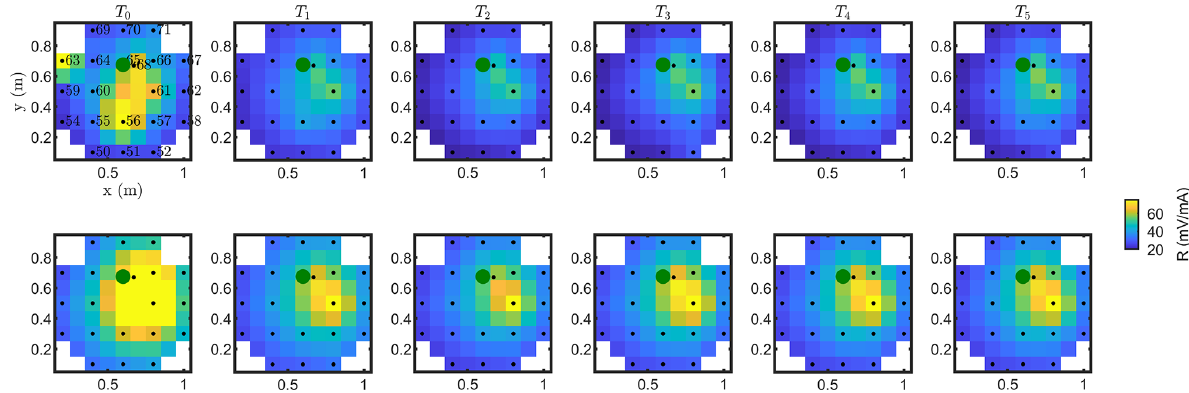
Figure C2. Resistance distribution of the raw data of MALM time-lapse monitoring for plant A. First-line results are relevant to the stem injection, while the second line refers to the soil control injection. Columns describe time evolution according to Table 1.